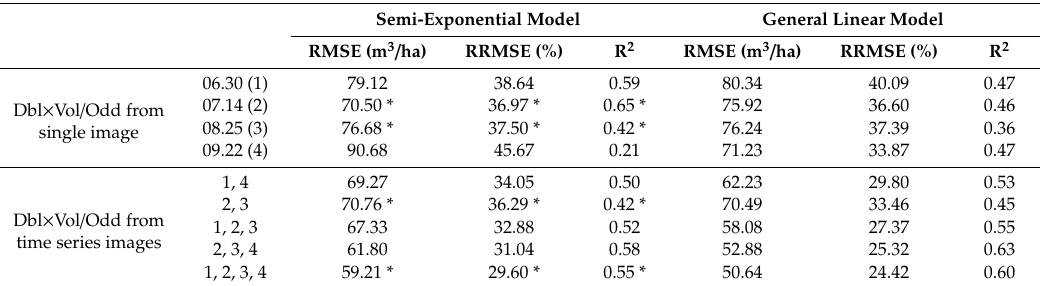
Table 5. The GSV estimated by the semi-exponential model and GLM using Dbl × Vol / Odd. Semi-Exponential Model General Linear